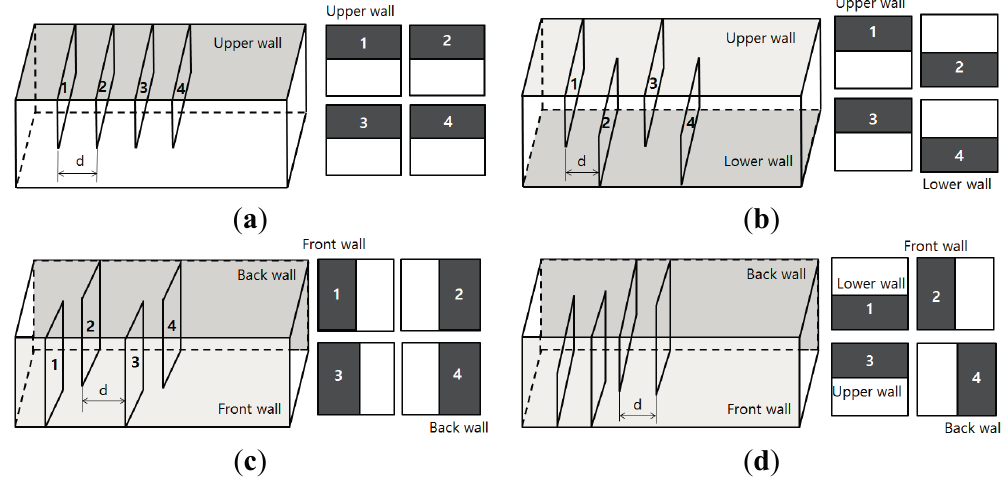
Figure 2. Schematic diagrams of four different configurations of repeated baffles. ( a ) Upper wall attachment. ( b ) Opposite wall attachment: type 1. ( c ) Opposite wall attachment: type 2. ( d ) Cyclic